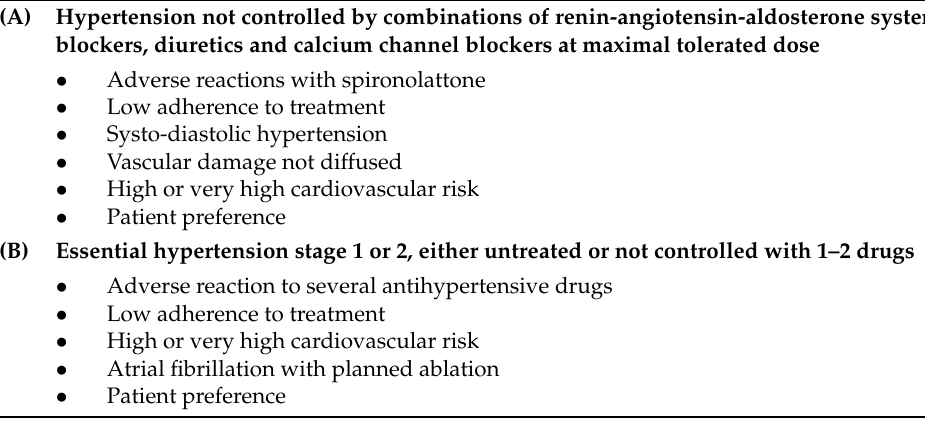
Table 1. Clinical features of patients who may be candidates to renal denervation. Adapted from a position paper of the Italian Society of Hypertension